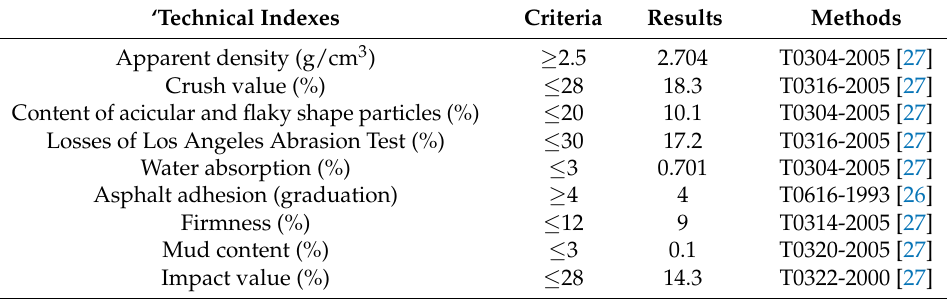
Table 3. Coarse aggregate properties.